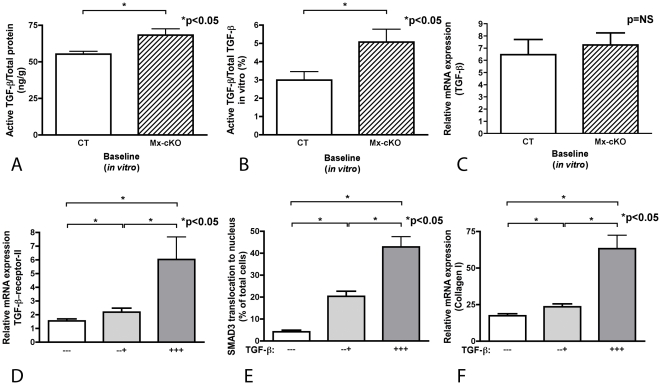
TGF-β content and signaling in vitro.(A) Active TGF-β is increased in conditioned media from unstimulated Mx-cKO stellate cells in culture compared to CT cells. After isolation, stellate cells were cultured for 24 hours on plastic, media were then changed and conditioned media (using fibronectin-depleted serum) were collected after an additional 24 hours. Active TGF-β was determined by ELISA in the media. Total protein was determined in cell lysates. N = 7 wells/group. (B) The amount of active TGF-β corrected to total TGF-β was increased in Mx-cKO cultures because total TGF-β did not differ in both groups (Data not shown). Active TGF-β was determined in the conditioned media and total TGF-β was determined in the medium together with the cell layer. N = 10 CT and 8 Mx-cKO pairs. (C) No difference in relative TGF-β mRNA expression by qPCR between untreated Mx-cKO and CT cells is found. N = 10 wells/group. (D) Repeated exposure to 10 ng/ml TGF-β increases TGF-β-receptor-II mRNA expression in wild-type stellate cells in culture compared to one time exposure only. (−−−): Cells cultured for 24 hours (time 0) were left untreated for an additional 24 hours, (−− +): Cells were left untreated at time 0 and 16 hours later, and were stimulated with TGF-β at 20 hours. Cells were stained and mRNA collected after 24 hours, (+ + +): Cells were stimulated with TGF-β at time 0 and then after 16 and 20 hours, and cells were stained and mRNA collected after 24 hours. N = 5 wells/condition. (E) Same experimental design was used as in D, and the graph shows that repeated exposure to TGF-β results in increased SMAD3 translocation to the nucleus. N = 4 wells/condition. (F) Same experimental design was used as in D, and the graph shows that repeated exposure to TGF-β results in increased collagen-type-I mRNA expression in comparison to one time exposure only. N = 5 wells/condition.